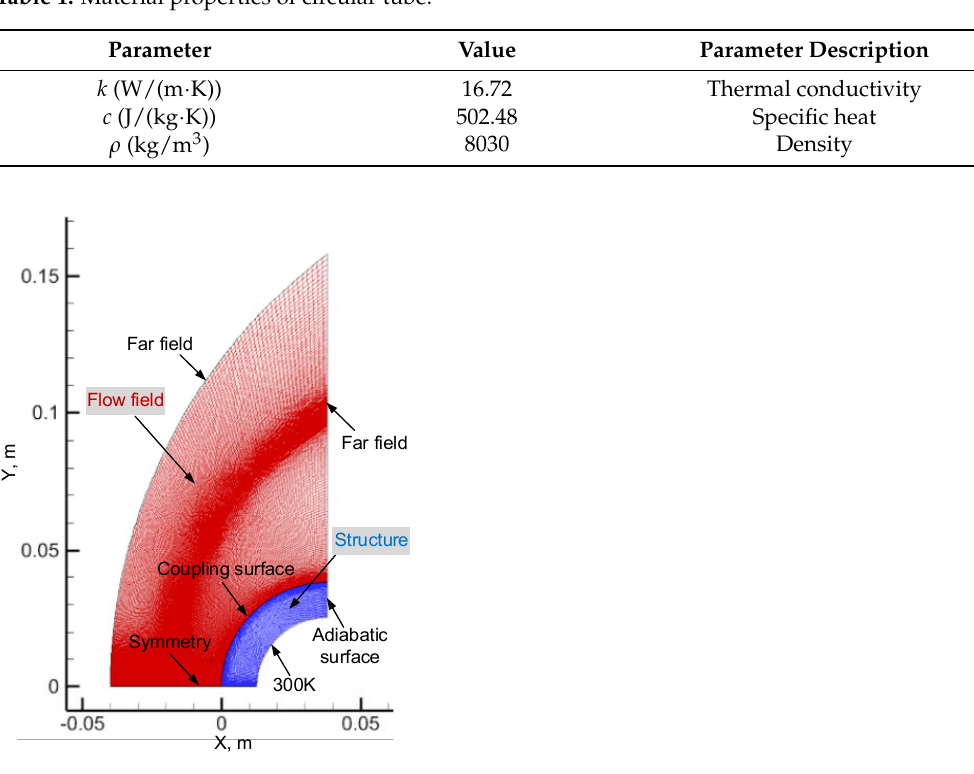
Figure 2. Computational grids and boundary conditions. Table 2. Parameters of hypersonic